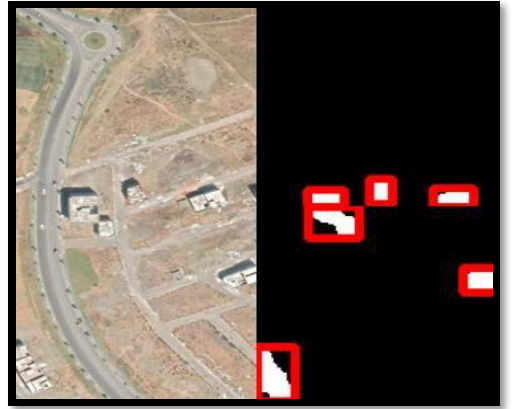
Fig. 6 : Satellite image and corresponding mask with buildings identified in white.